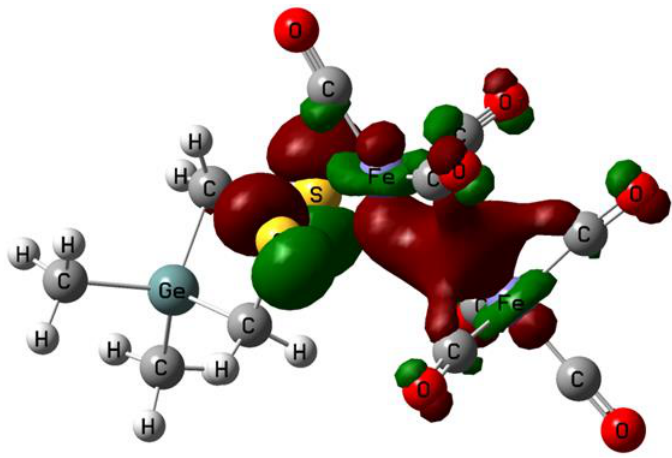
Figure 4. Highest occupied molecular orbital, HOMO, of P1 .